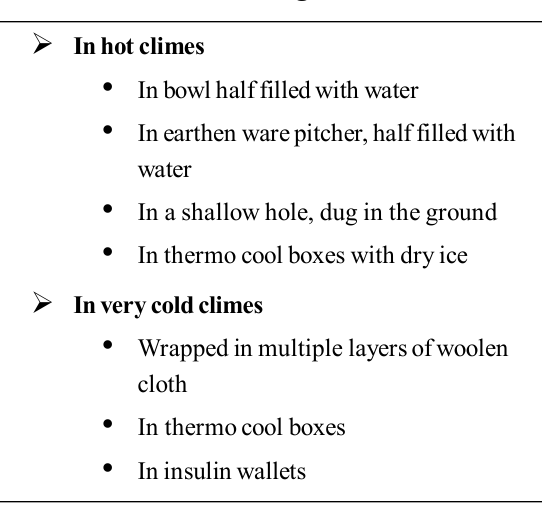
Table 2. Alternative methods of insulin storage